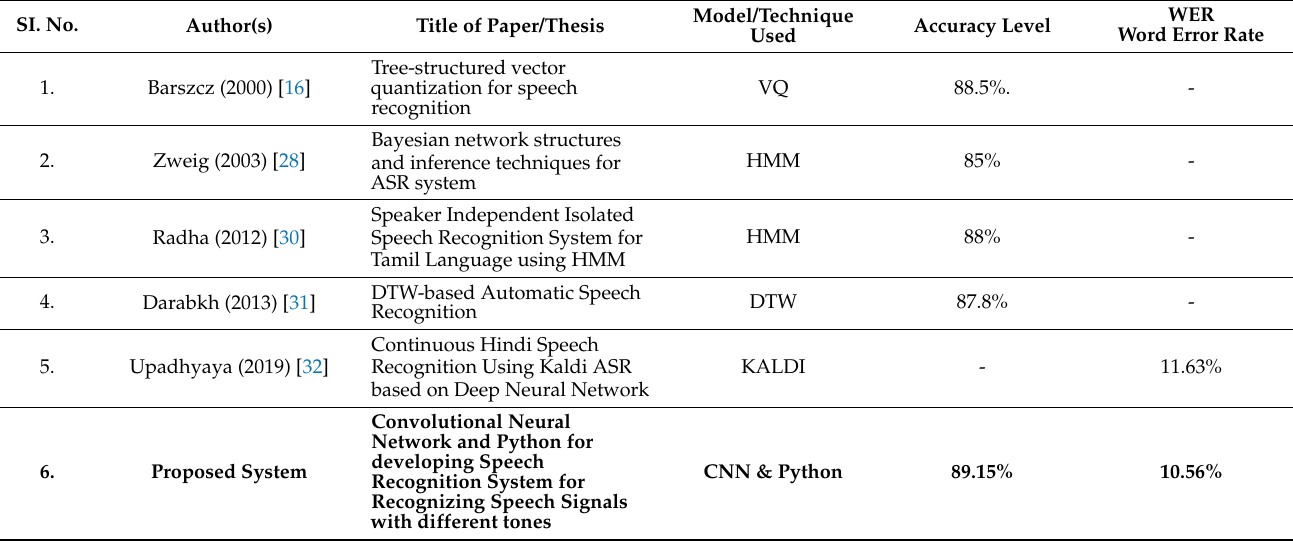
Table 7. Comparison of different techniques with proposed technique.